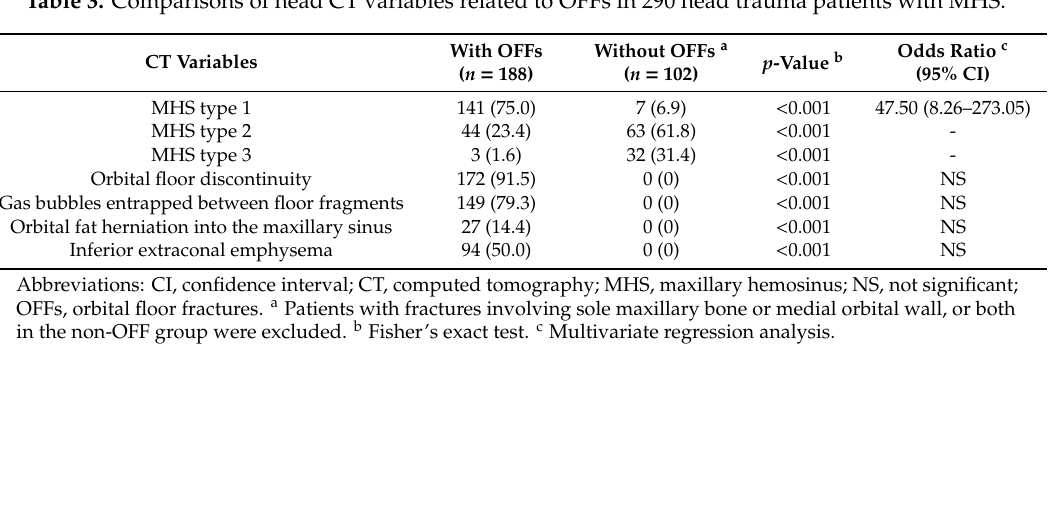
Table 3. Comparisons of head CT variables related to OFFs in 290 head trauma patients with